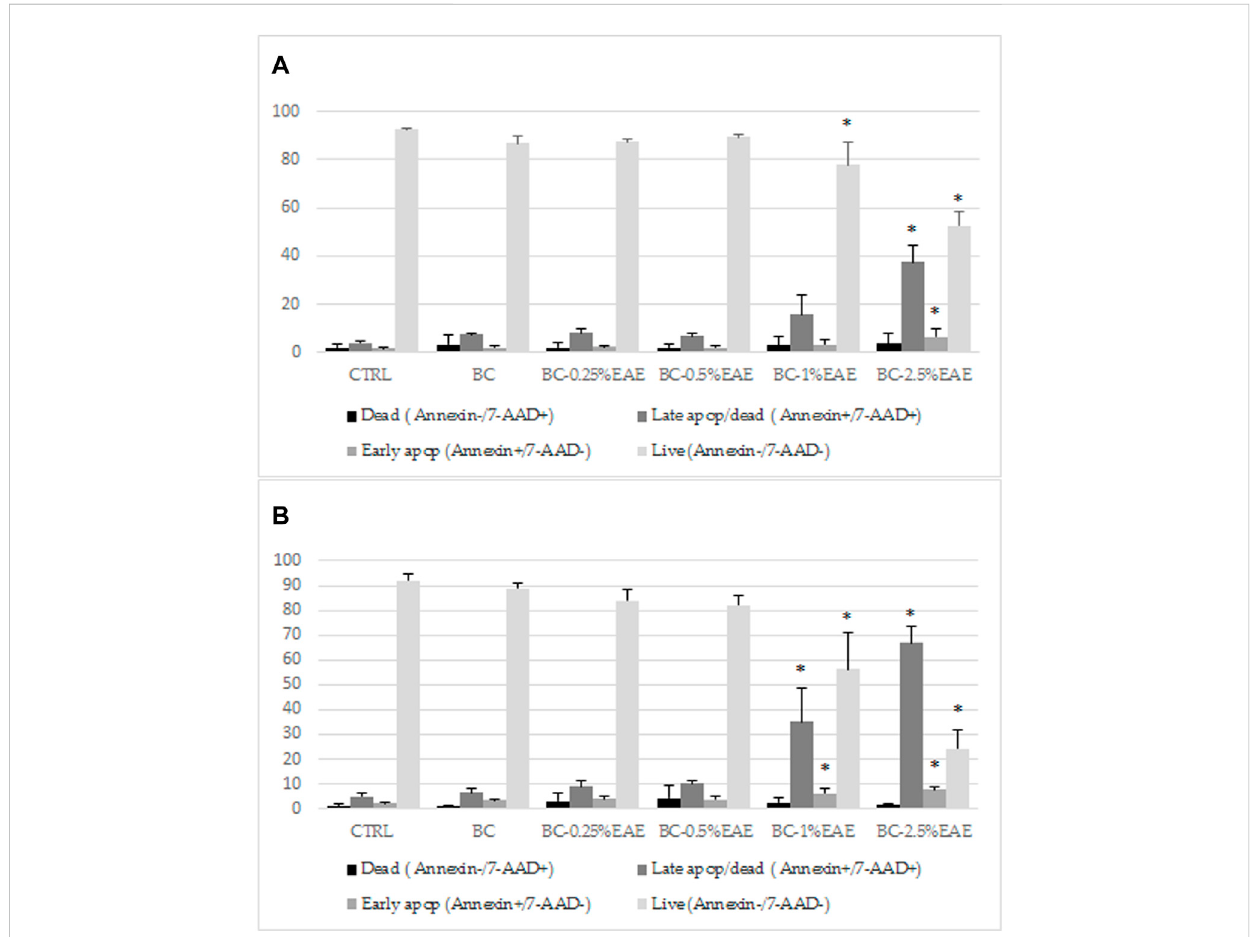
FIGURE 10 The effect of indicated compounds on the induction of apoptosis in HT-29 cells after 48 h (A) and 72 h (B) of treatment, subsequently stained with Annexin V-PE and 7-AAD and analyzed by fl ow cytometry. Data are expressed as mean and SD from three independent experiments; * p < 0.05 vs. ctrl (ANOVA test followed by a post hoc Tukey ’ s multiple comparisons